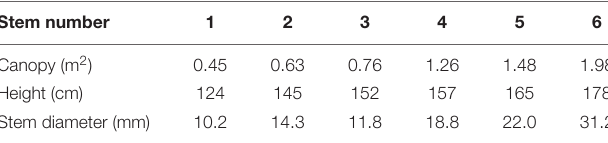
TABLE 1 | Characteristics of selected stems of Tamarix ramosissima ( T . ramosissima ).